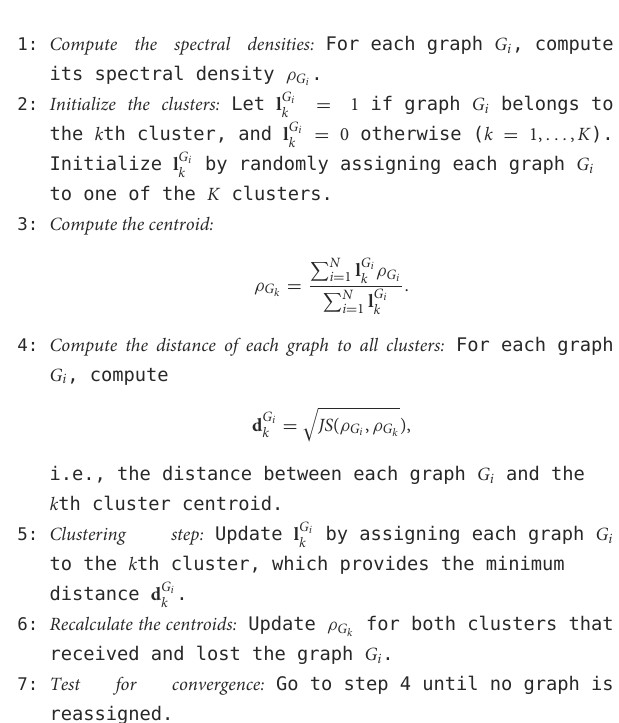
Algorithm 1. K-means graph clustering algorithm. Input : The N graphs and the number of clusters K